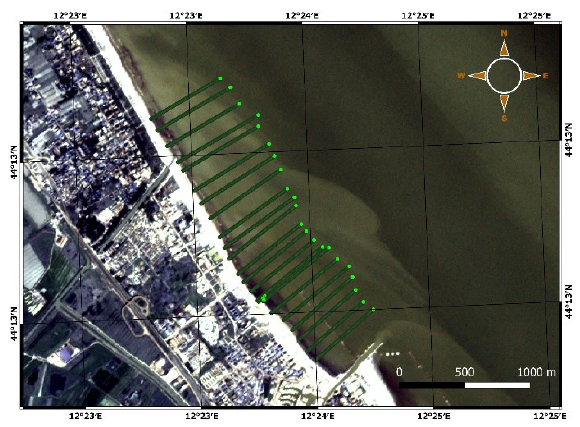
Figure 2. Points of water depth